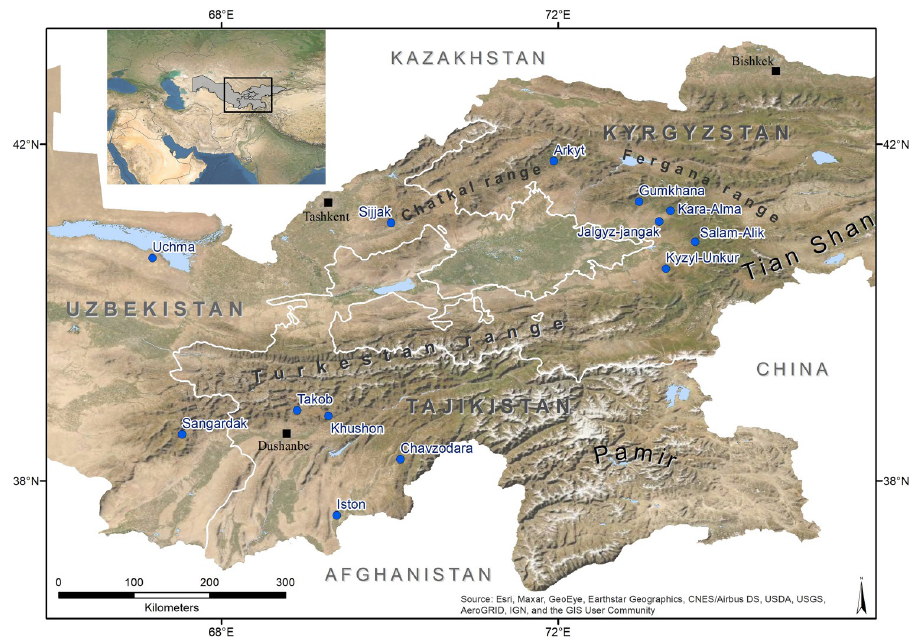
Fig 1. Map of the study sites in the three countries. The blue dots indicate the sites where field work was conducted.